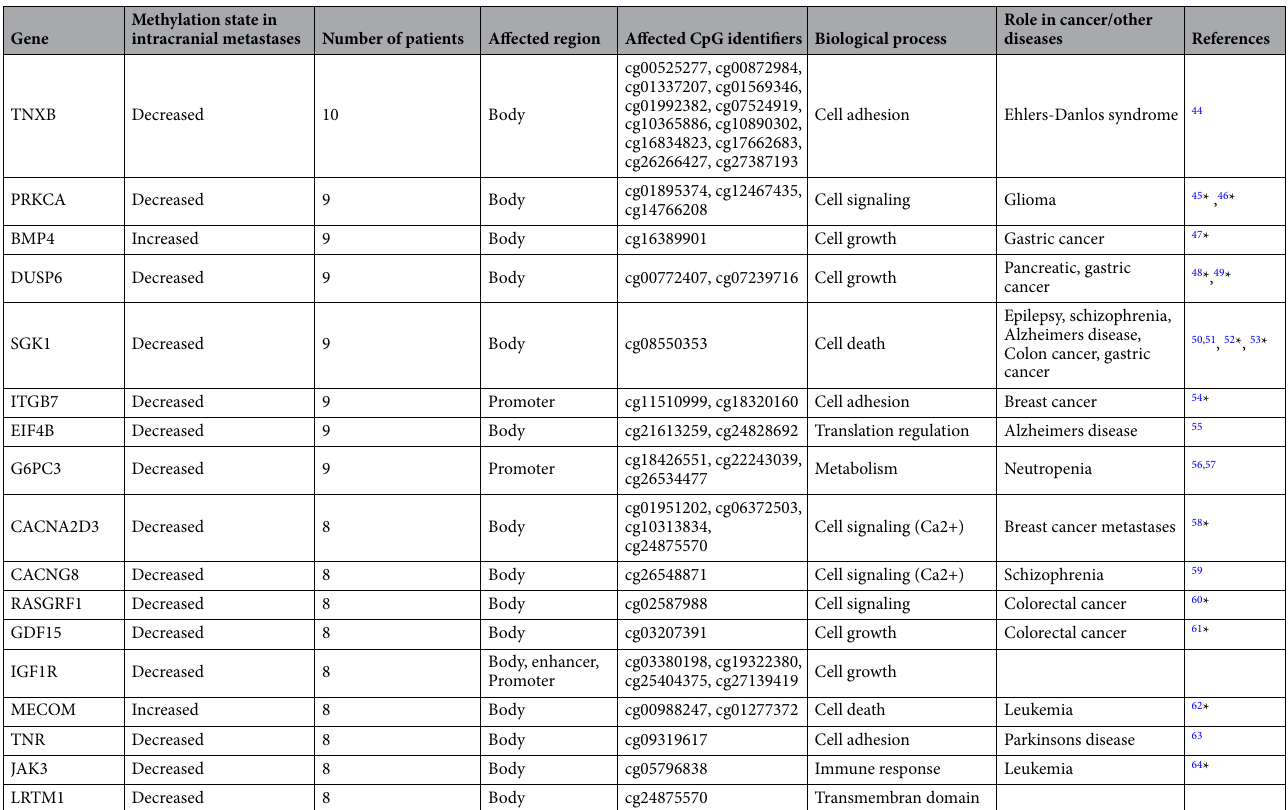
Table 2. Top differentially methylated signaling pathway genes distinguishing intra- from extracranial metastases. The table represents in-depth information about the 17 signaling pathway genes that contained at least one CpG whose methylation level was altered in the same direction in at least 8 of 14 patients. The observed methylation change in intracranial metastases is reported in the column ‘Methylation state in intracranial metastases’ along with the number of patients whose metastases pair showed the same behavior provided in the column ‘Number of patients’. The affected region of a gene is provided in the column ‘Affected region’, affected CpGs are listed in the column ’Affected CpG identifiers’, and corresponding gene functions from GeneCards 65 and Uniprot 66 are summarized in the column ’Biological process’. Results of an in-depth literature analysis in relation to cancer and other diseases are summarized in the column ‘Role in cancer / other diseases’. Relevant references are listed in the column ’References’. References that indicate associations of a specific gene in relation to cancer are marked with an asterisk